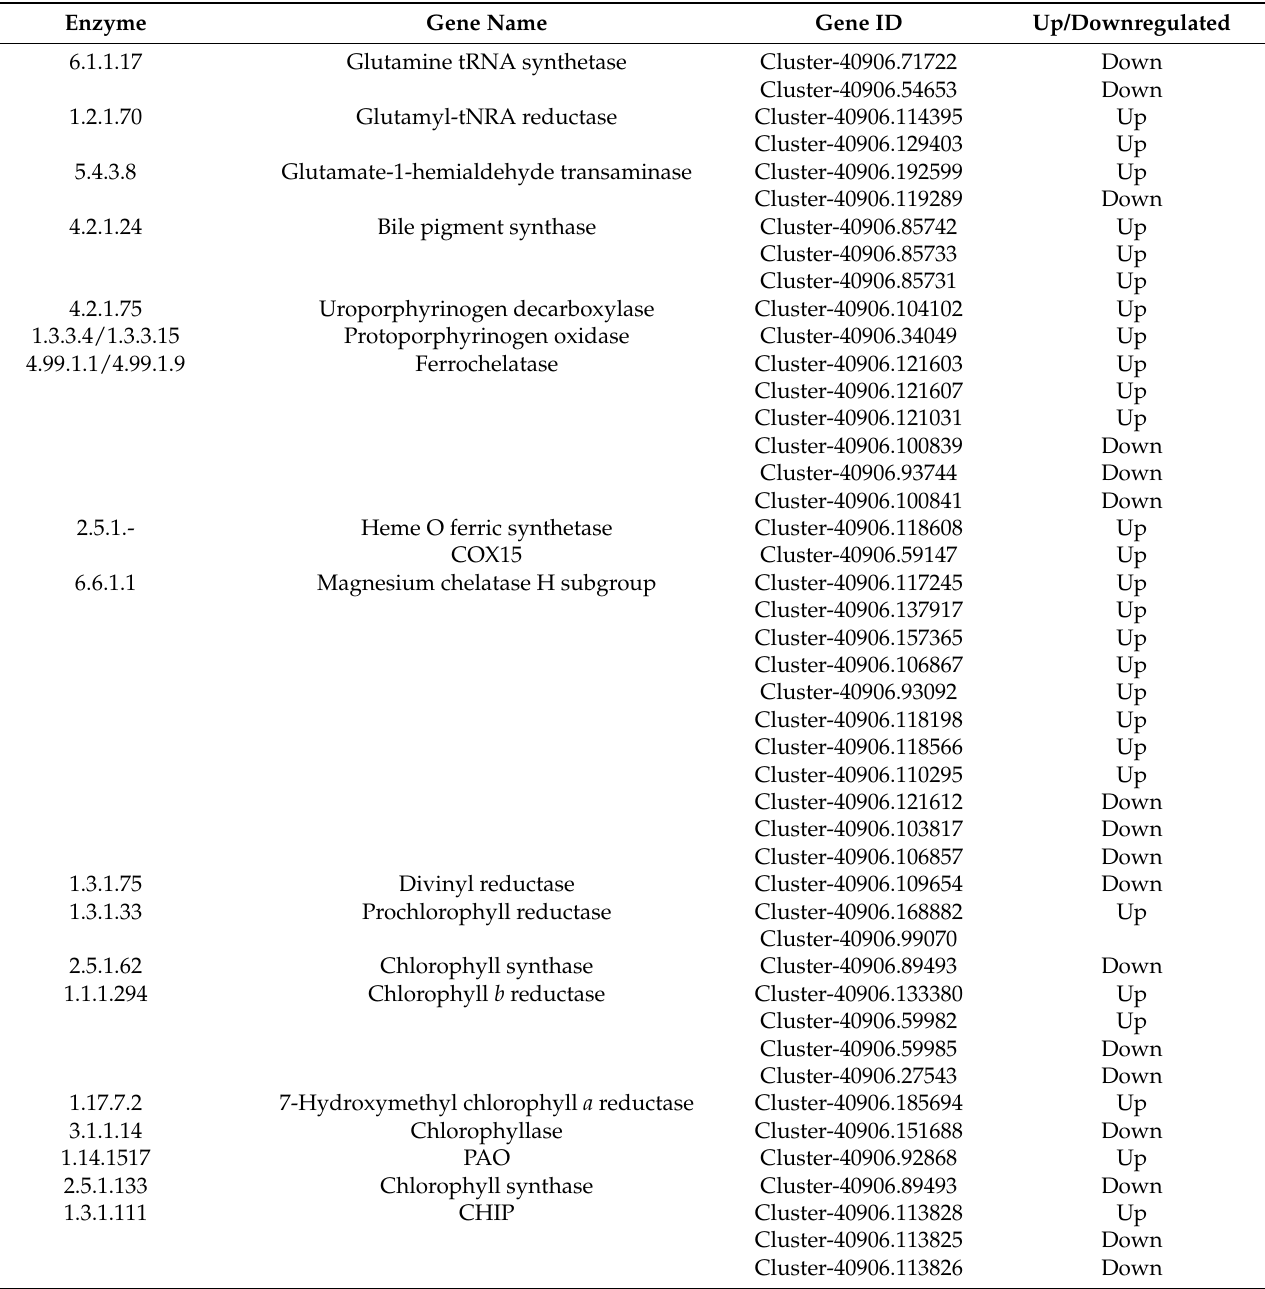
Table 5. Effect of drought treatment on relating functional genes of porphyrin and chlorophyll metabolism in N. tangutorum